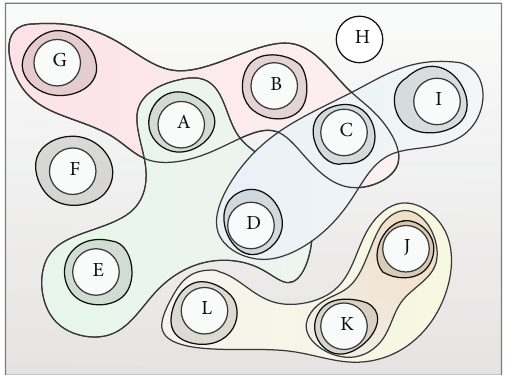
Figure 4: Conceptual problems (circles) and solutions (irregular forms). Instead of looking at the whole ADE and CDI problems found in two different games and solving them directly, solving problem D twice in the process, it is more interesting to identify the individual problems A, C, D, E, and I and solve them once first. A solution based on those of the individual problems can then be developed for each game without having to solve them